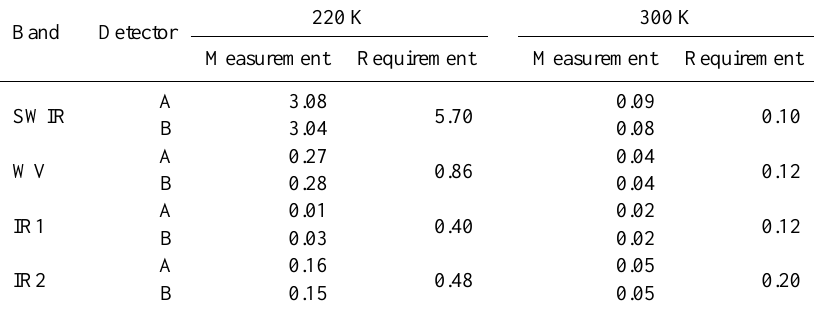
Table 4. The noise performance of COMS/MI for each detector with the user-required specifications for two different conditions: 220 and 300K. The measurement values are given for each detector, although the requirement is the same for the same for each detector in the same channel. 220 K 300 K Band Detector Measurement Requirement Measurement Requirement